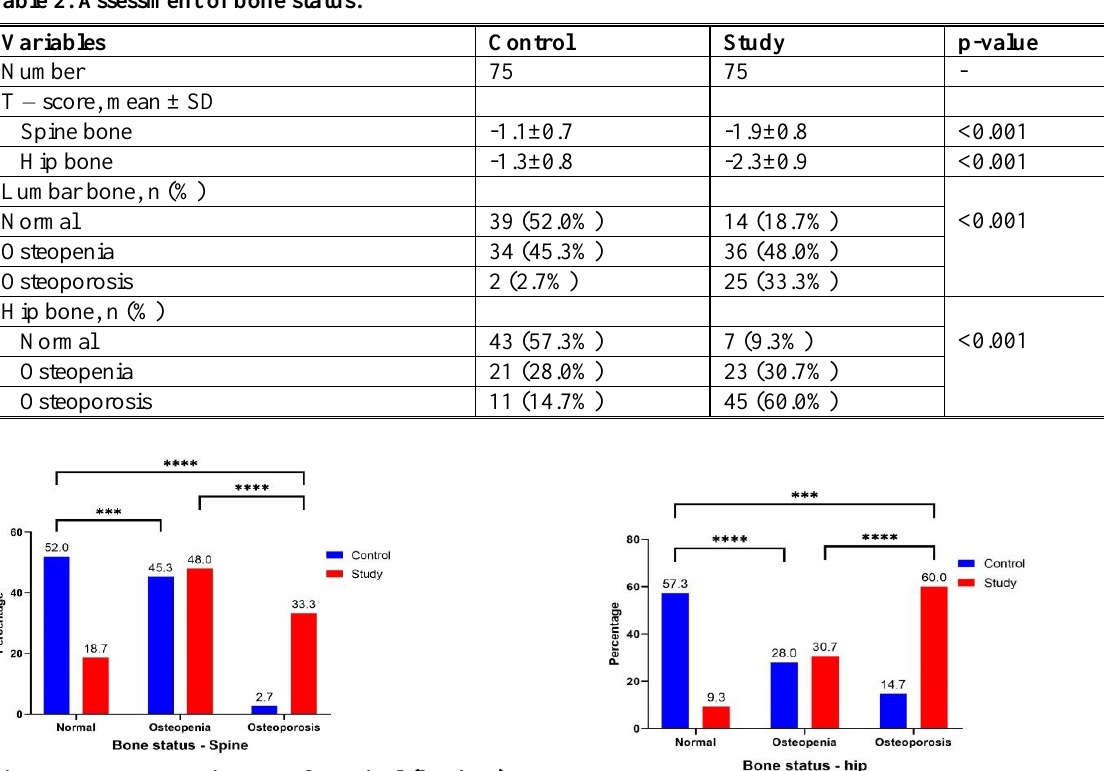
Figure 1. Osteoporosis status for spinal (lumbar) Table 3. Ordinal regression analysis of the predictor of osteoporosis for lumbar bone in the study